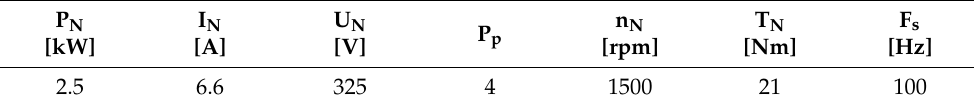
Figure 18. Photos and general diagram of experimental set-up. Table 4. Parameters of the tested motor.